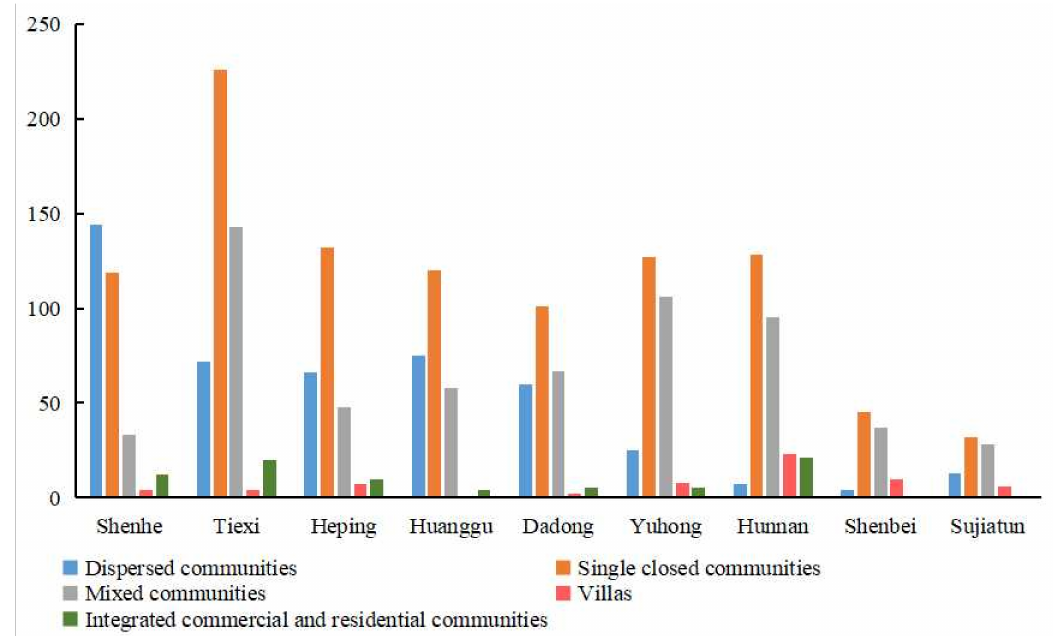
Figure 5. Residential communities number in different regions.